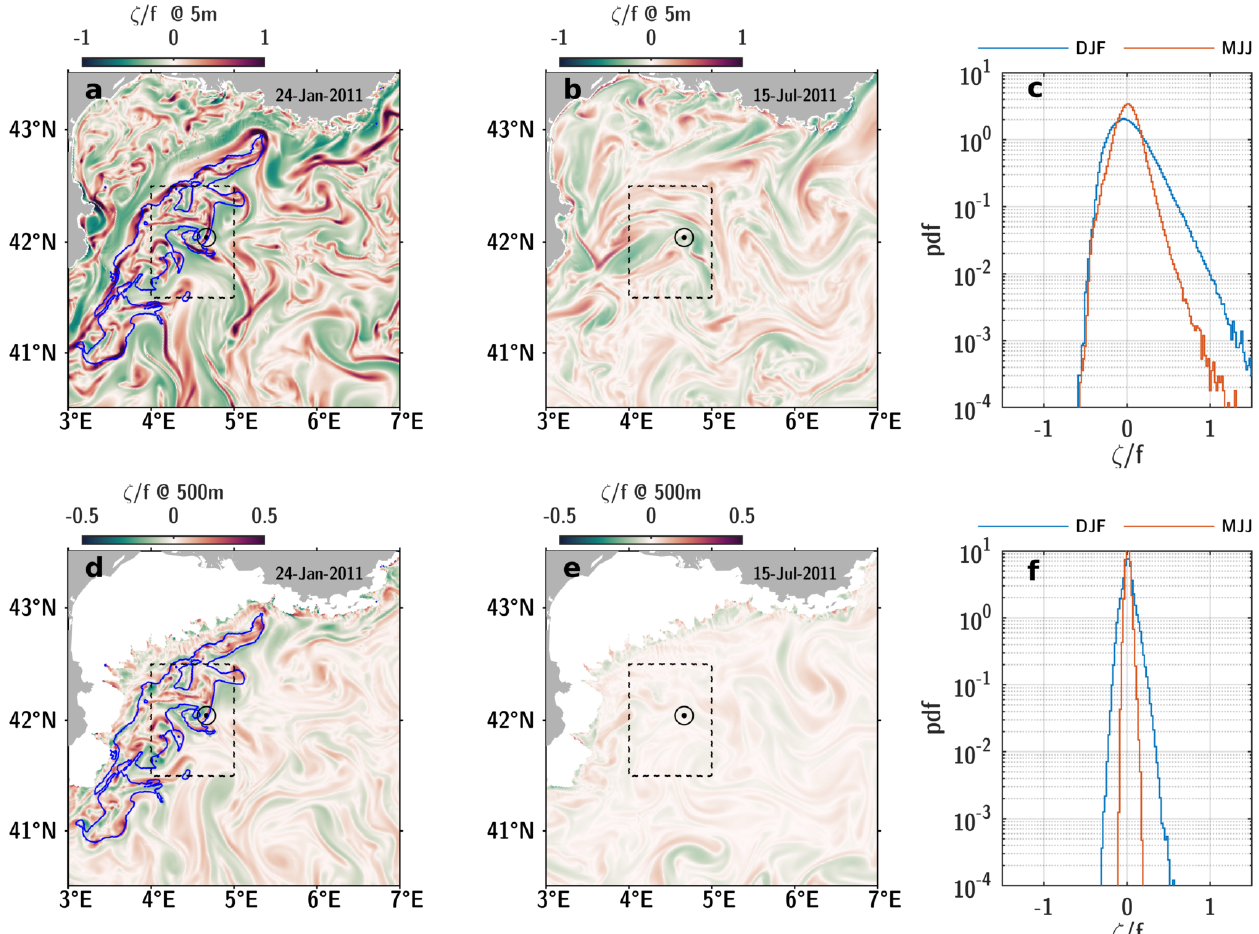
Figure 4. Relative vorticity normalized by f from SYMPHONIE model at 5m during ( a ) the winter (snapshot on 24 January, 2011), ( b ) the summer (snapshot on 15 July 2011). The blue contour shows the 500m MLD area. The black dot indicate the LION mooring site. ( c ) Histogram of relative vorticity during the winter months (December to February) in blue and the summer months (May to July) in red in the box indicated by a dashed line rectangle. ( d – f ) Same at 500m depth with different colorbar